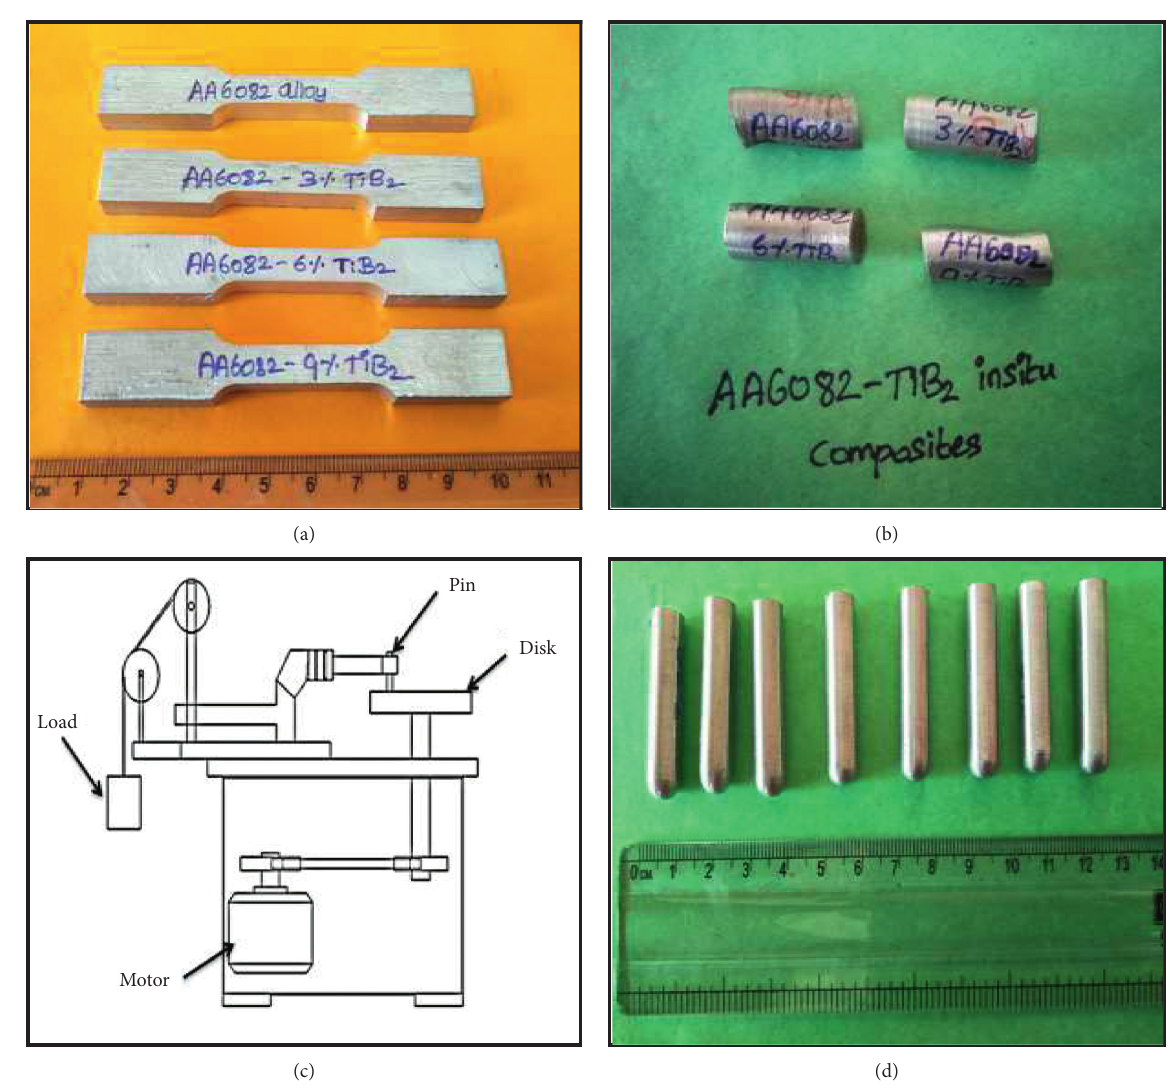
Figure 2: (a) Tensile test samples. (b) Compression test samples. (c) Schematic illustration of tribometer. (d) Wear